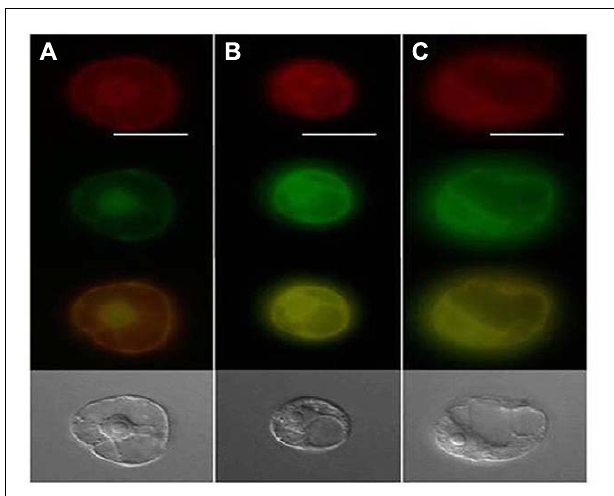
FIGURE 3 | Epifluorescence microscopy of endoplasmic reticulum (ER) and GFP localization where ER (red) on top panel, GFP (green) in second panel, merged green/red in third panel and the bottom panel displays the transmitted light images. Panel (A) showsTMV 30B-GFPc3 (GFPc3 is GFP where ER localization signal have been removed) inoculated cells while (B) shows cells that were inoculated withTMV GFP:P34, and (C) is cells inoculated withTMV P34:GFP. Image fromWang etal. (2010) with